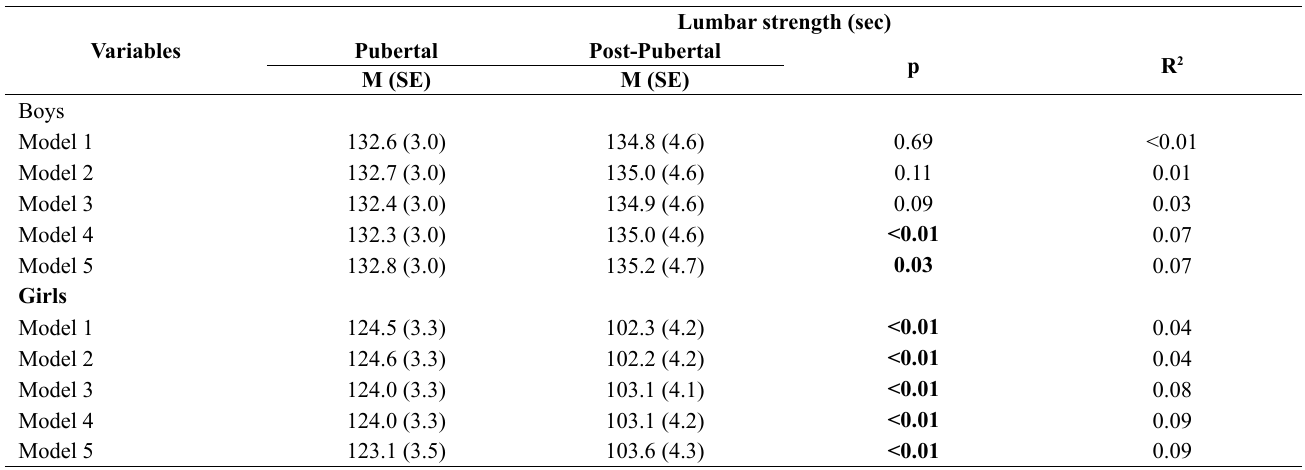
Table 4. Comparison of lumbar force between pubertal and post-pubertal adolescents.